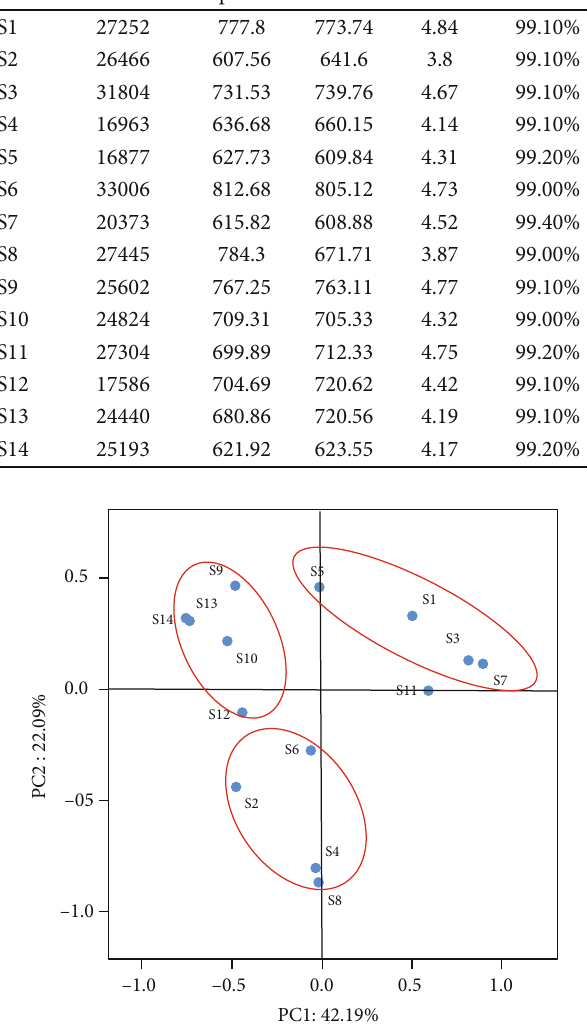
Table 5: Microbial diversity indices based on 97% identity of 16S rRNA gene sequences. Sample Sequences